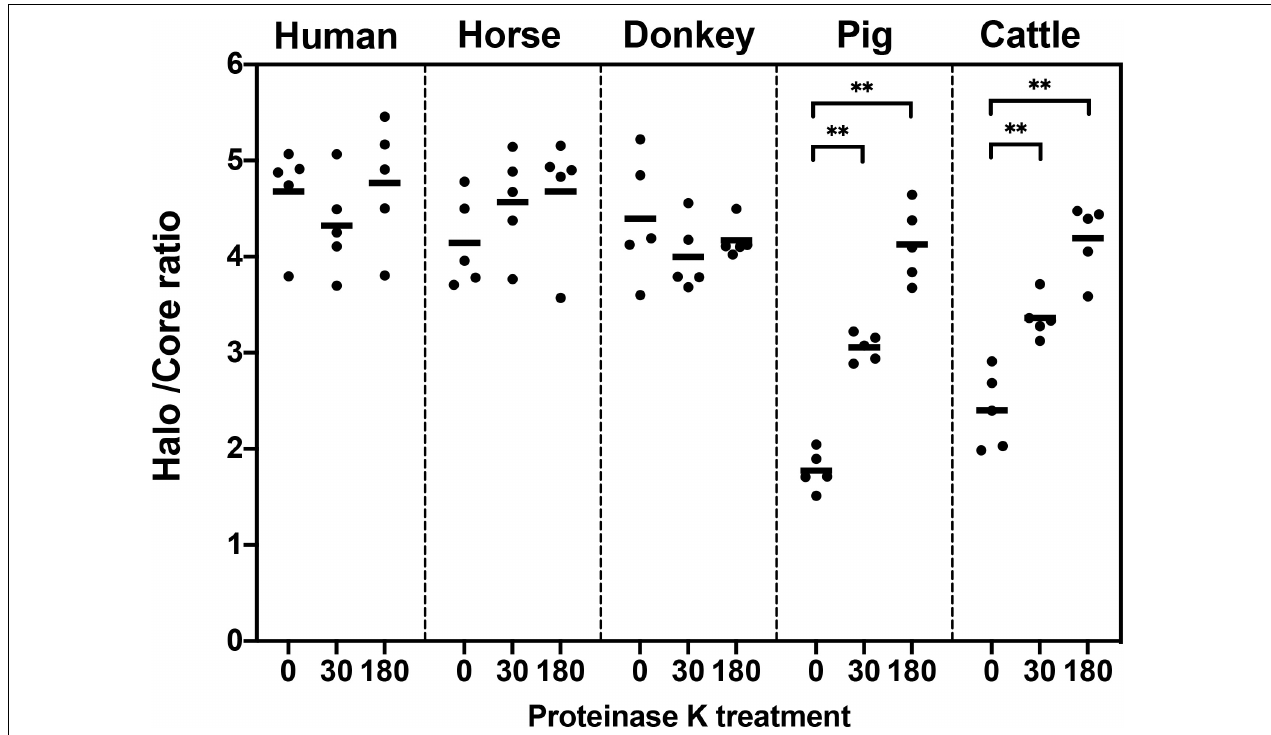
FIGURE 3 | Halo/core ratio in relation to proteinase K treatment (0, 30, or 180 min). ∗∗ Statistically significant differences ( P < 0.05). TABLE 2 | DNA decondensation of pig and cattle sperm after incubation in the third lysis solution with or without proteinase K. Pig Cattle Incubation time (min) − Proteinase K + Proteinase K − Proteinase K + Proteinase K Core with ( µ m)